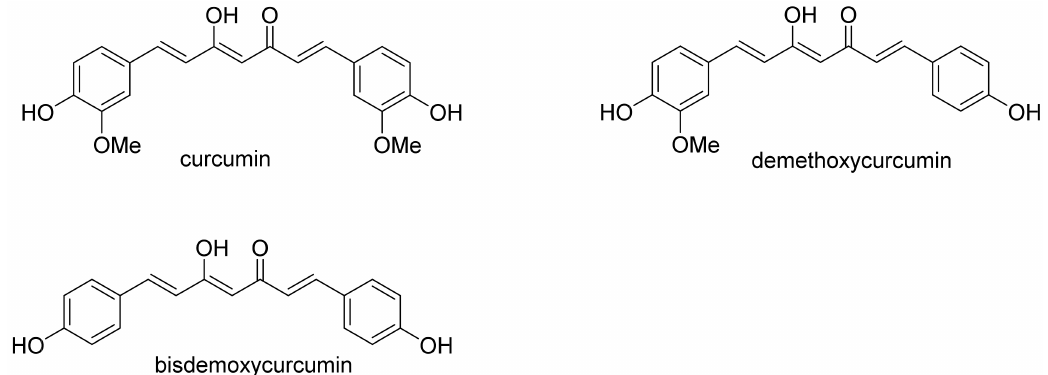
Figure 1. The most abundant constituents of natural curcuminoids.